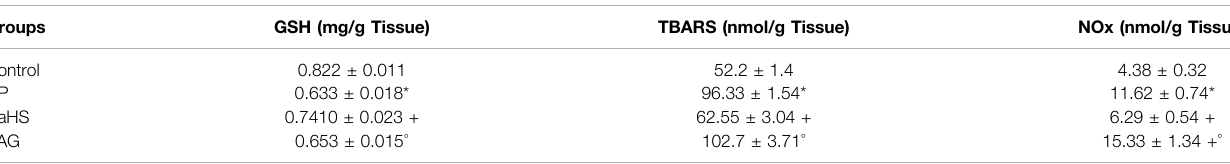
TABLE 1 | Effects of NaHS and PAG in CP-induced hepatotoxicity in rats.